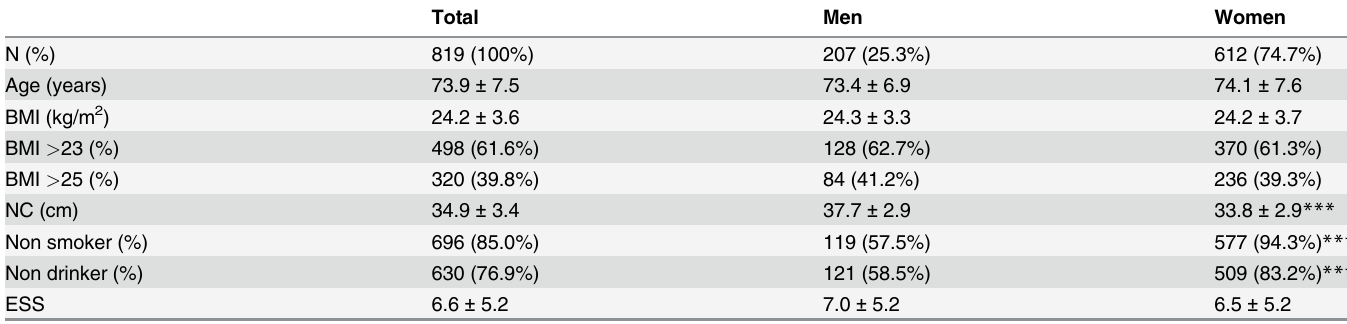
Table 1. Clinical data of the studied population (N = 819) according to gender (Mean ± SD).